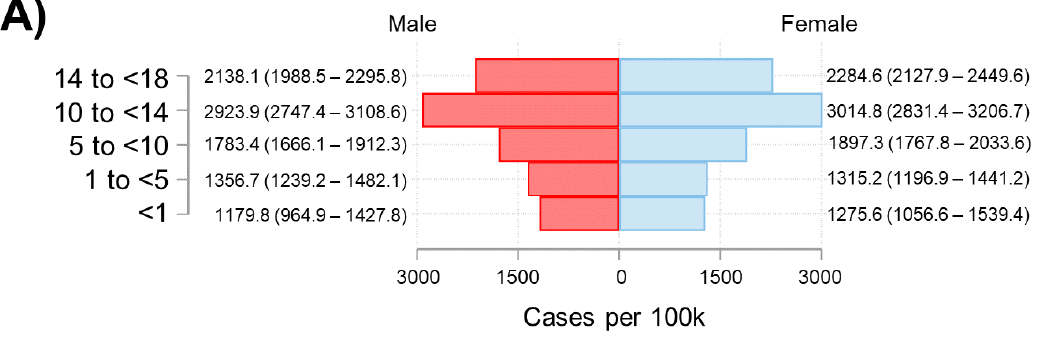
Figure 5. Distribution of cases by gender and age, as of 31 April 2021. The distribution of confirmed new cases in Cartagena and other municipalities of Bolívar per 100,000 population was plotted in Panel ( A , B ), respectively. The 95% confidence intervals of the cumulative incidences were in paren- thesis. 4. Discussion The transmission patterns and epidemiology of COVID-19 in individuals under 18 years old have been sparsely documented [8,9,11,17]. This lack of information hinders ef- forts to understand the underlying dynamics between epidemic peaks and the burden of COVID-19 [26]. In addition, insufficient information prevents prioritization for vaccina- tion or booster vaccination of population subgroups at increased risk of severe disease or long-term COVID-19 complications among infants, children, and adolescents [5,9]. To our knowledge, this is the most comprehensive evaluation of the dynamics and epidemiology of COVID-19 in the Colombian department of Bolívar among individuals under 18 years, from the first reported case in March 2020 to April 2021. The testing capacity has been crucial for the rapid and opportune investigation of COVID-19 cases as part of the various pandemic response and control activities [36]. Re- garding the exploratory aim, our findings suggest that the information reported by the reference laboratory UNIMOL reflected the early dynamics of COVID-19 for Cartagena and other municipalities in Bolívar. Interestingly, although UNIMOL collaborated contin- uously with the PHL for the SARS-CoV-2 community-based testing in suspected cases throughout Bolívar, the information generated by UNIMOL was not sensitive enough to detect the increase of COVID-19 cases in Cartagena between July and September 2020, and November and February 2020, as well as the increase between August and September 2020 for other Bolívar municipalities (Figure 1). The reduced sensitivity to detect epidemic